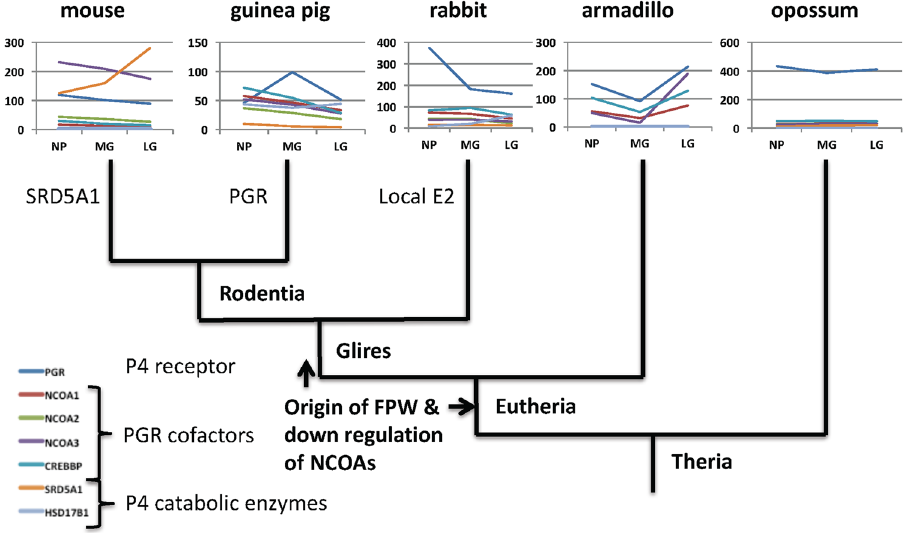
Figure 7. Evolutionary steps in the evolution of putative mechanisms of functional progesterone withdrawal. No modulation of genes related to steroid signaling is observed in opossum, while the expression of these genes is modulated in eutherian mammals suggesting that functional progesterone withdrawal evolved in the eutherian clade. The exact time of its evolution is not clear, because of incomplete data about the armadillo. It could be as early as the eutherian stem or the stem of Glires. Other putative mechanisms are species specific, with putative local estradiol synthesis in rabbit, PGR decrease in guinea pig and up-regulation of SRD5A1 in mouse.